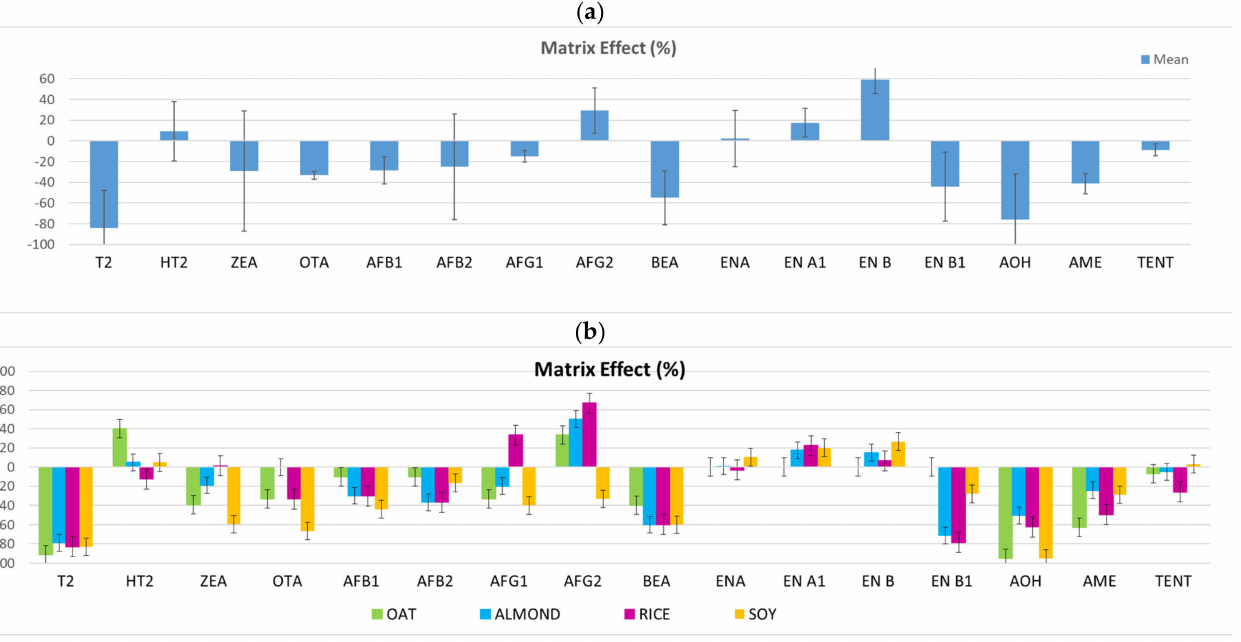
Figure 3. Average matrix effect ( a ) and matrix effect ( b ) for each mycotoxin of each studied